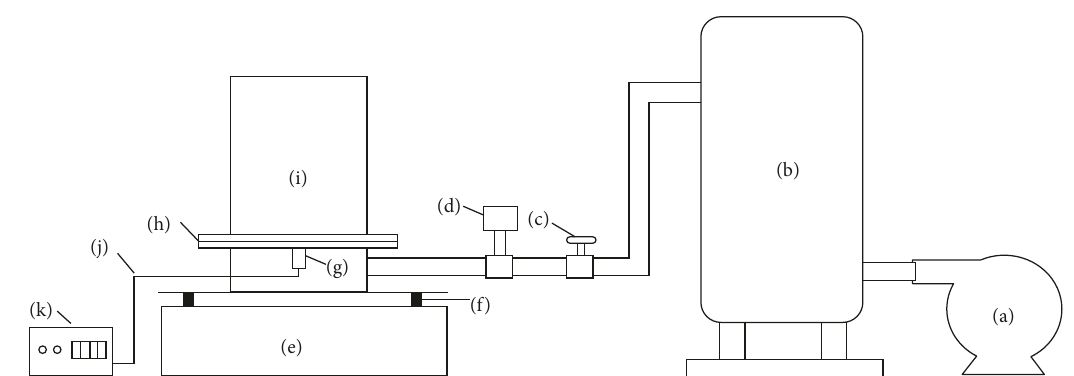
Figure 1: Schematic diagram of the experimental system: (a) roots blower; (b) air reservoir; (c) air valve; (d) vortex flow meter; (e) pedestal; (f) spring; (g) ultrasonic transducer; (h) air distribution plate; (i) fluidized bed; (j) cable; (k) ultrasonic power supply.